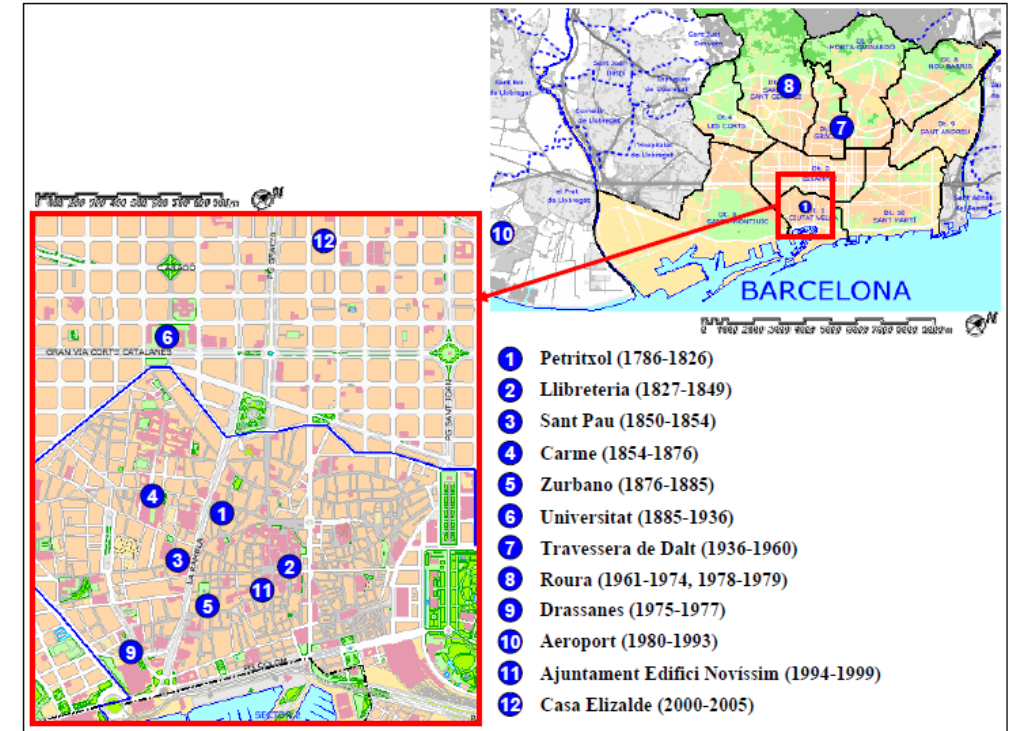
Fig. 3. Barcelona daily rainfall series (1786–2006). Location of rainfall observatories during this period.